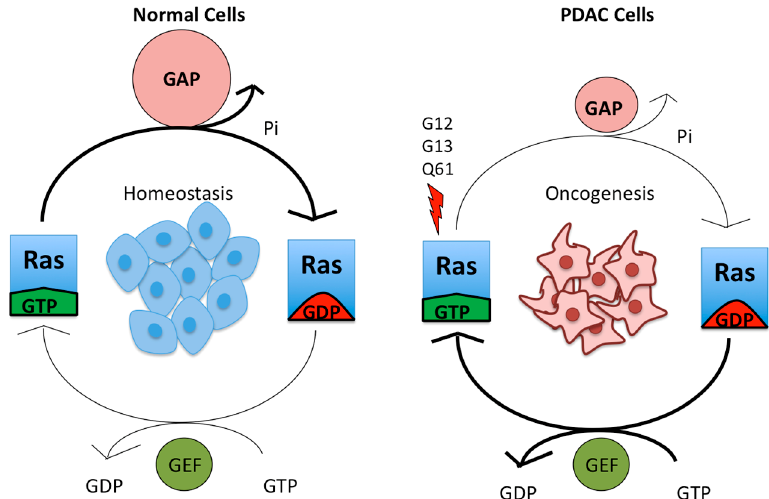
Figure 2. Mutant KRAS is continuously in a GTP ‐ bound, active state. Wild ‐ type KRAS cycles between an active, GTP ‐ bound and an inactive, GDP ‐ bound state, and it exists largely in an inactive state in non ‐ dividing cells. Upon growth factor stimulation, normal KRAS is activated by RAS guanine nucleotide exchange factors (RASGEFs), which facilitate the binding of GTP to KRAS. KRAS ‐ GTP then binds downstream effectors. This signaling is attenuated due to the action of RAS GTPase ‐ activating proteins (RASGAPs), which promote the hydrolysis of the bound GTP to GDP and hence formation of inactive KRAS ‐ GDP. Mutation of residues G12, G13 or Q61 constitutively activates KRAS by preventing the formation of van der Waals interactions between RAS and RASGAPs [20] and interfering with the position of a water molecule necessary for GTP hydrolysis [21], respectively. The arrow thickness and relative size of the symbols for GEFs and GAPs indicate the level of signaling.